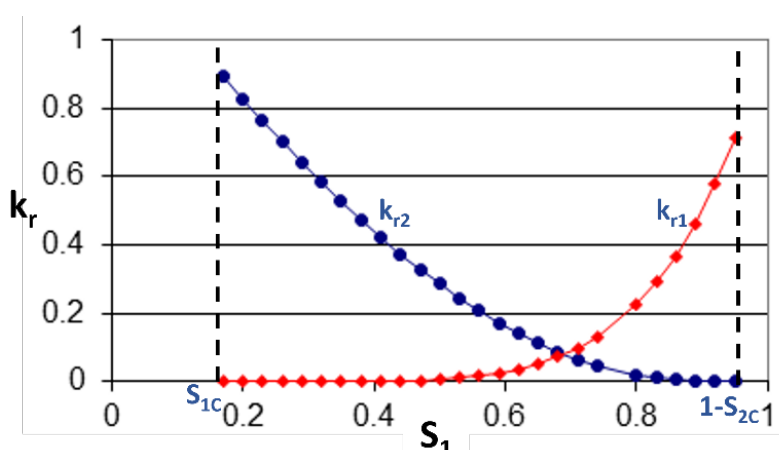
Figure 3. Relative permeabilities of Fluids 1 and